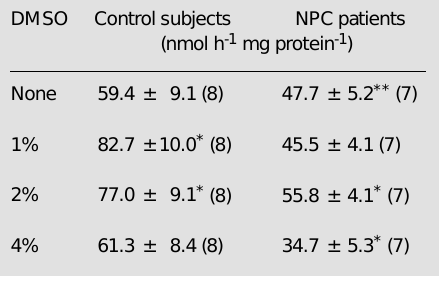
Table 2 - Effect of DMSO on the amount of cho- lesterol in cultured fibroblasts from patients with Niemann-Pick type C disease.